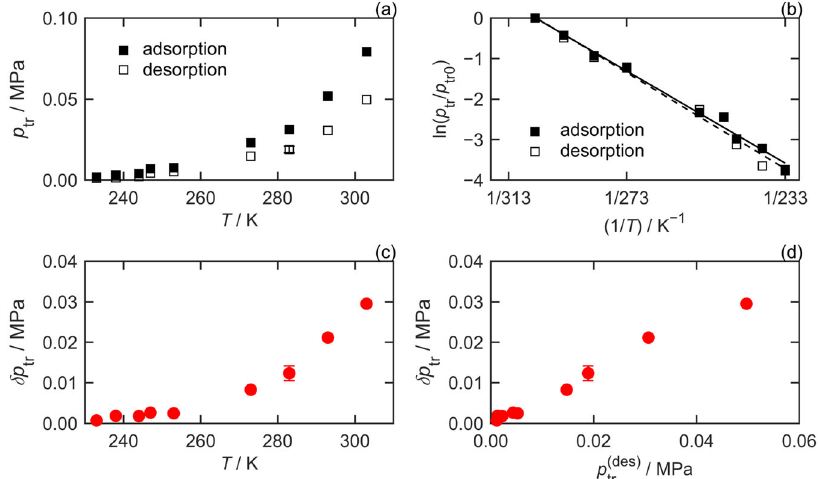
Fig. 4 Limiting behavior of transition pressures and hysteresis parameters. Squares denote transition pressures, p tr , measured in adsorption (solid symbols) and desorption (hollow symbols), as a function of a temperature, T or b relative to the transition pressure at 303 K, p tr0 , for CO 2 on ZIF-7. Circles denote the hysteresis of the isotherm ’ s transition pressure, δ p tr , with c temperature and d with the transition pressure measured in desorption, p ð des Þ